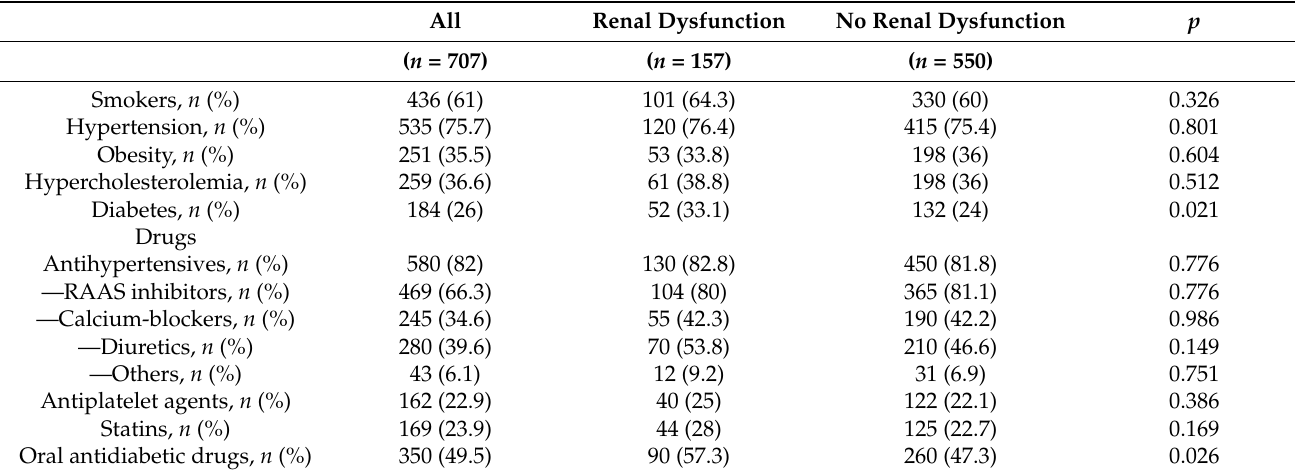
Table 2. Cardiovascular risk factors and therapies, stratified according to the presence or absence of renal dysfunction (eGFR < 60 mL/min/1.73 m 2 ) at